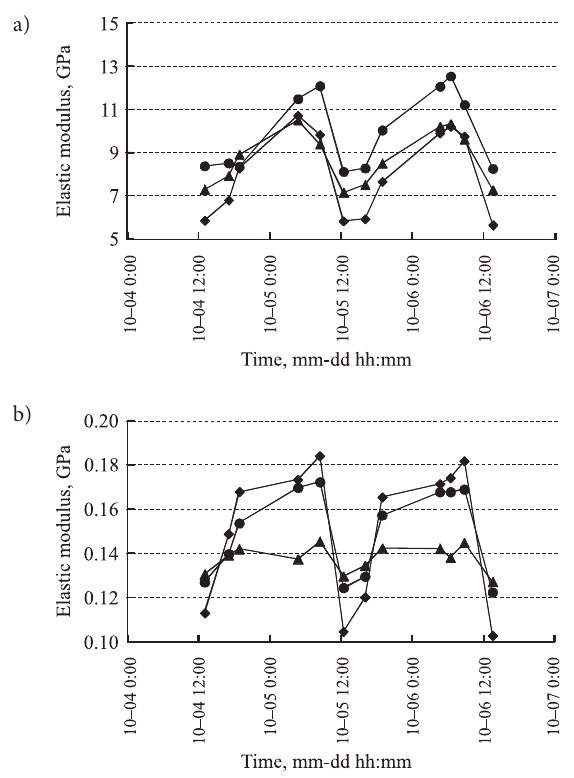
Fig. 7. Elastic modulus of subbase and subgrade backcalculated by MET: a – lean concrete subbase; b – subgrade: Section 4–0 slab (120 mm Thk. subbase); Section 5–0 slab (170 mm